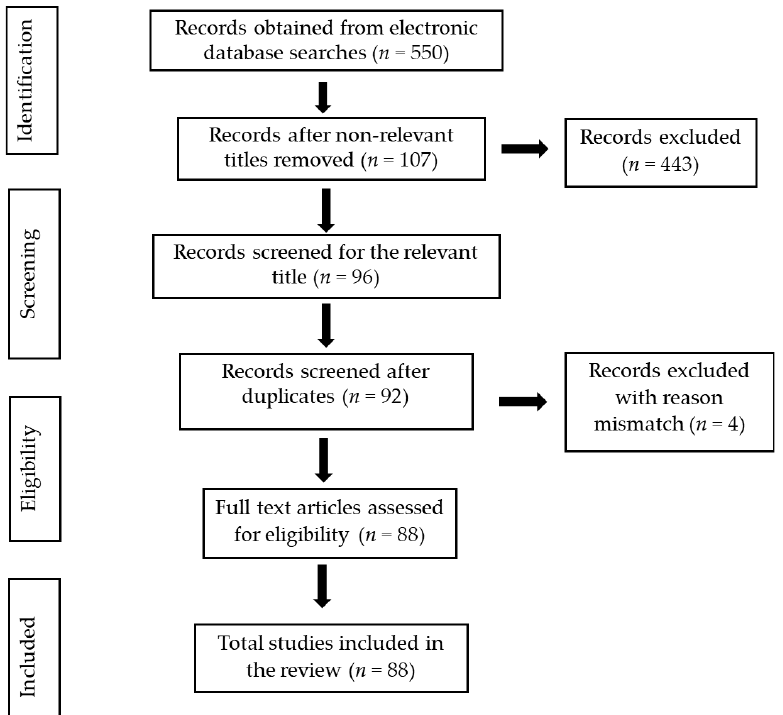
Figure 2. Schematic representation of the PRISMA chart explaining the selection of studies.